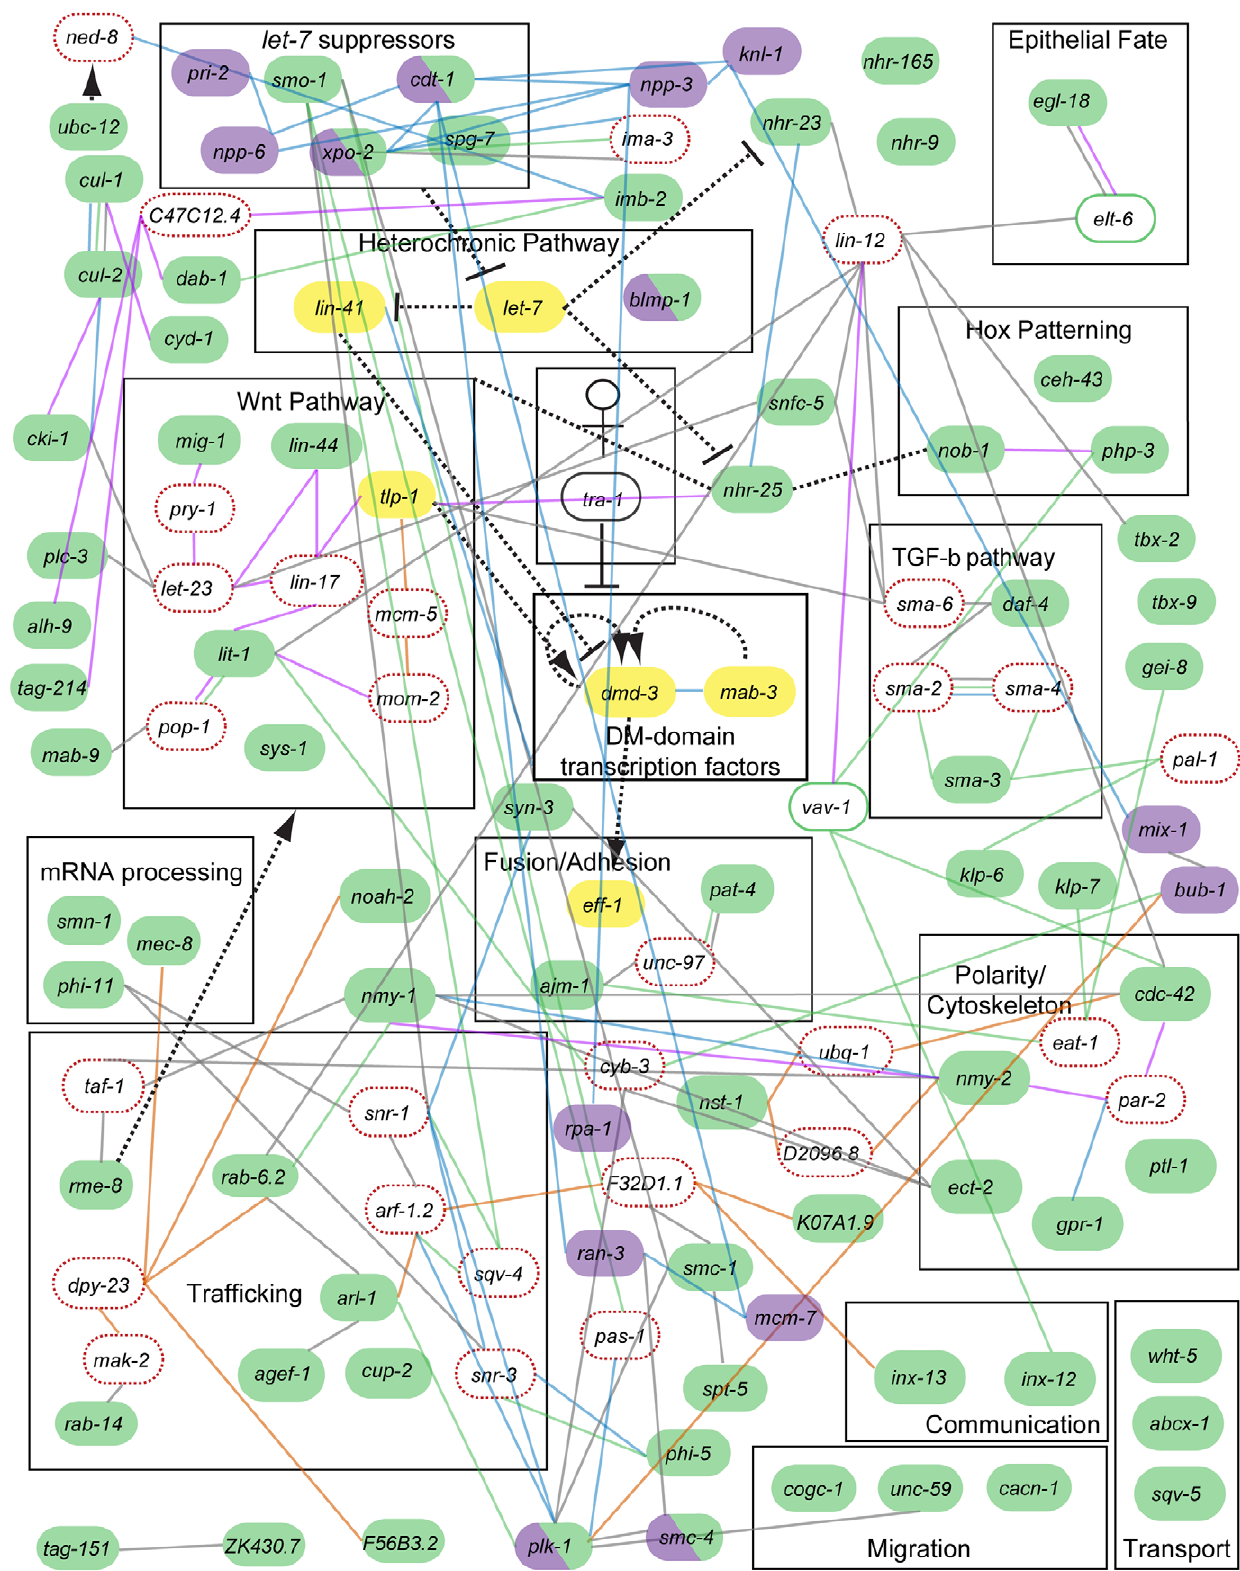
Figure 5. A partial genetic network of tail tip morphogenesis as predicted by N-Browse [17] (thin lines) and other published work (thick dashed lines) [7,44,57–59,61]. Clusters of pathways or functional groups are surrounded by boxes to represent their proximity within the network and/or functional interactions in modules. Nodes (genes): green, Lep positives identified in the screen; purple, Ore positives identified in the screen; green/purple, Lep + Ore positives from the screen; yellow, previously identified tail tip genes; green boundary (unfilled), not identified in the